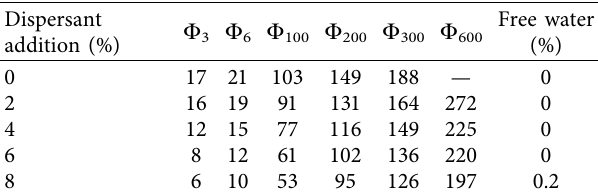
Table 5: Rheological properties of the cement slurry with different dispersant contents.